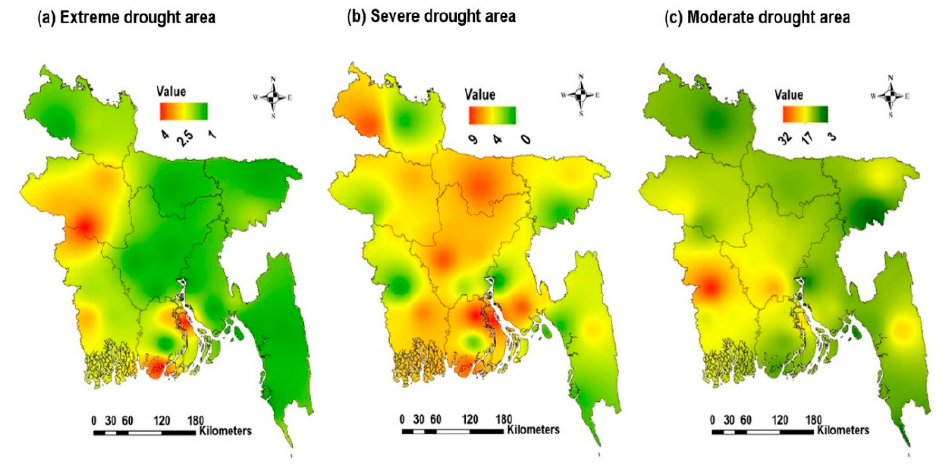
Figure 6. Spatial distribution of droughts during 1981–2015: ( a ) Extreme; ( b ) Severe; ( c ) Moderate